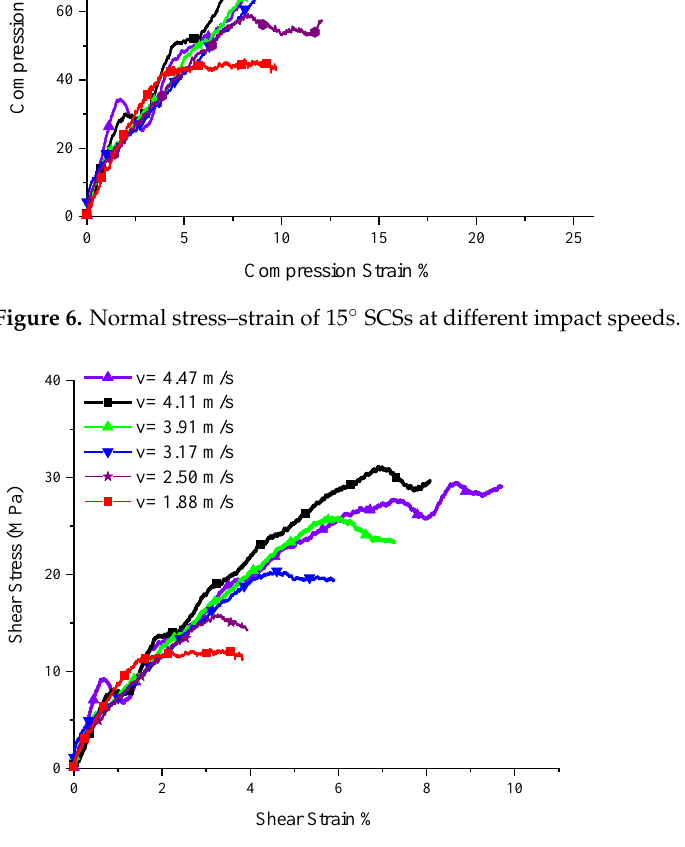
Figure 7. Shear stress–strain of 15° SCSs at different impact speeds.